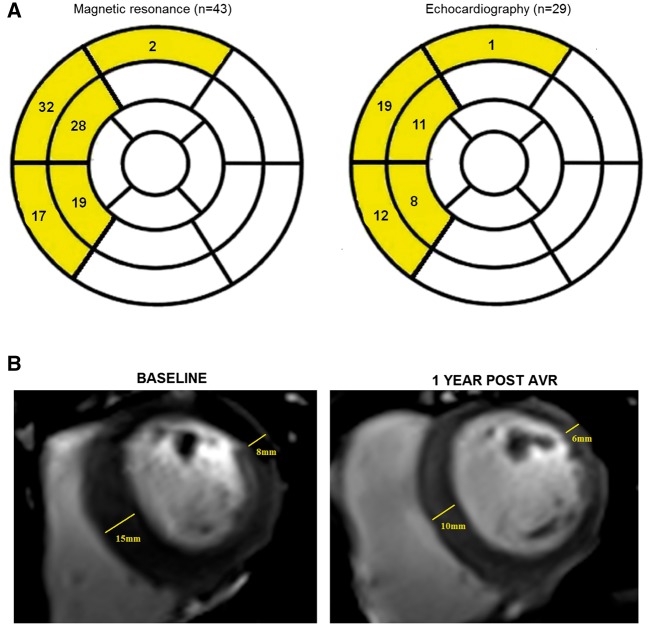
Prevalence, distribution, and resolution after aortic valve replacement of asymmetric wall thickening. (A) Seventeen segment model of the LV demonstrating the site of asymmetric wall thickening as detected by both magnetic resonance and echocardiography. Magnetic resonance was more sensitive in detecting asymmetric wall thickening (43 cases) than echocardiography (29 cases). On both modalities, asymmetric wall thickening was almost universally confined to the basal and mid-cavity segments of the septum. (B) Patient with asymmetric wall thickening at baseline, which resolved when magnetic resonance was repeated 1 year after aortic valve replacement.